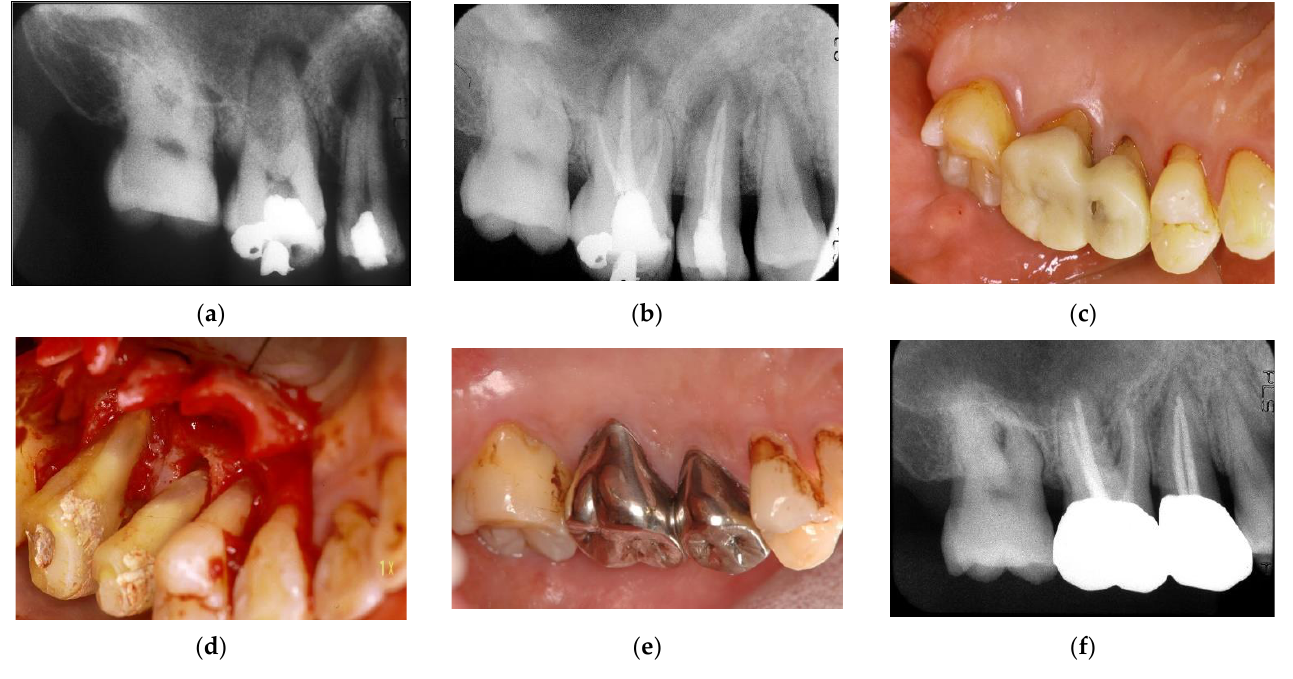
Figure 8. Clinical case 7. Male, age 54 yrs. ( a , b ) Periapical radiographs of the upper right second premolar and first molar at baseline, with the “bone” defect presenting as a radiolucent area around the root apex. In addition, deep pockets were present, and electric pulp tests were positive, suggesting retrograde pulpitis. ( b ) Periapical radiograph after root canal treatment. ( c ) Intraoral examination of the upper right molar before surgery (PD 9 mm). ( d ) View after flap retraction, debriding of the defects, and application of an enamel matrix derivative. ( e ) Final prosthesis 2 years later, presenting with healthy gingiva (PD < 3 mm). ( f ) Periapical radiograph 2 years later.